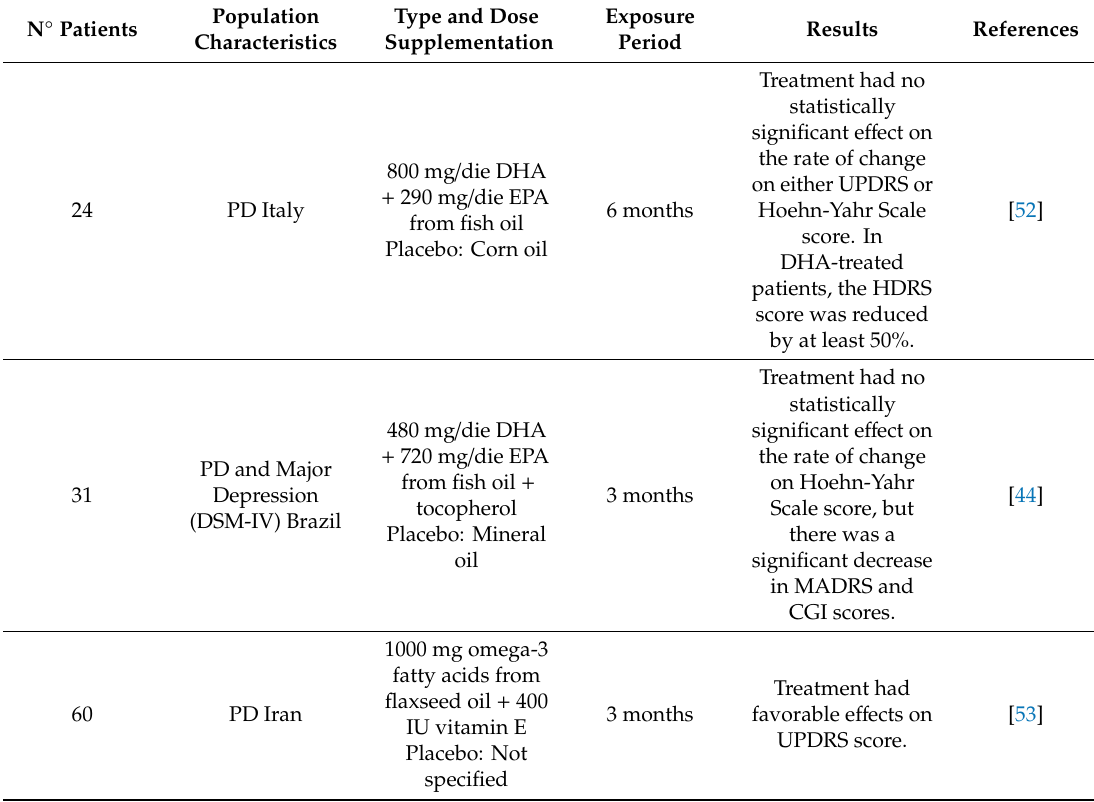
Table 5. Clinical trials assessing the impact of omega-3 fatty acids supplementation in PD patients. N ◦